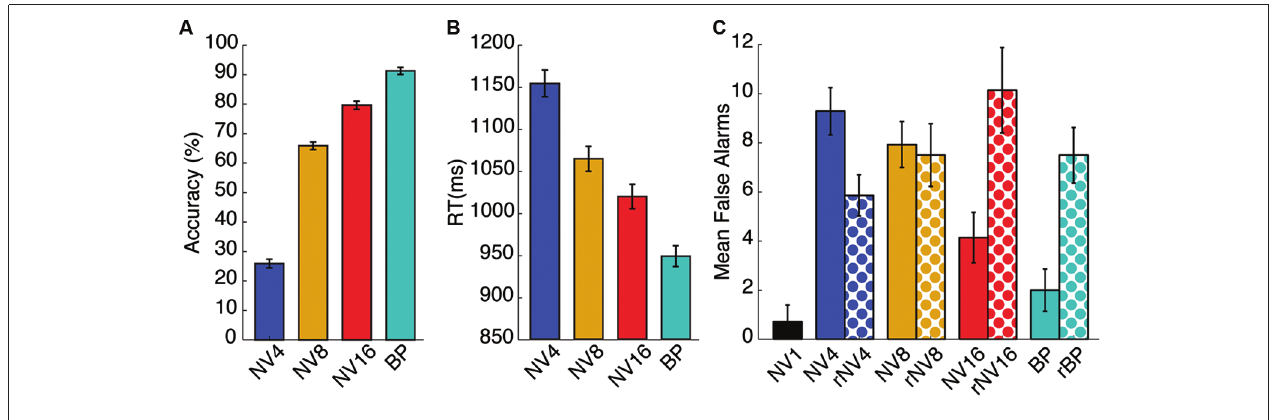
displays the mean number of false alarms for all conditions. Error bars represent standard error of the mean corrected to be appropriate for repeated-measures comparisons, as described in Loftus and Masson